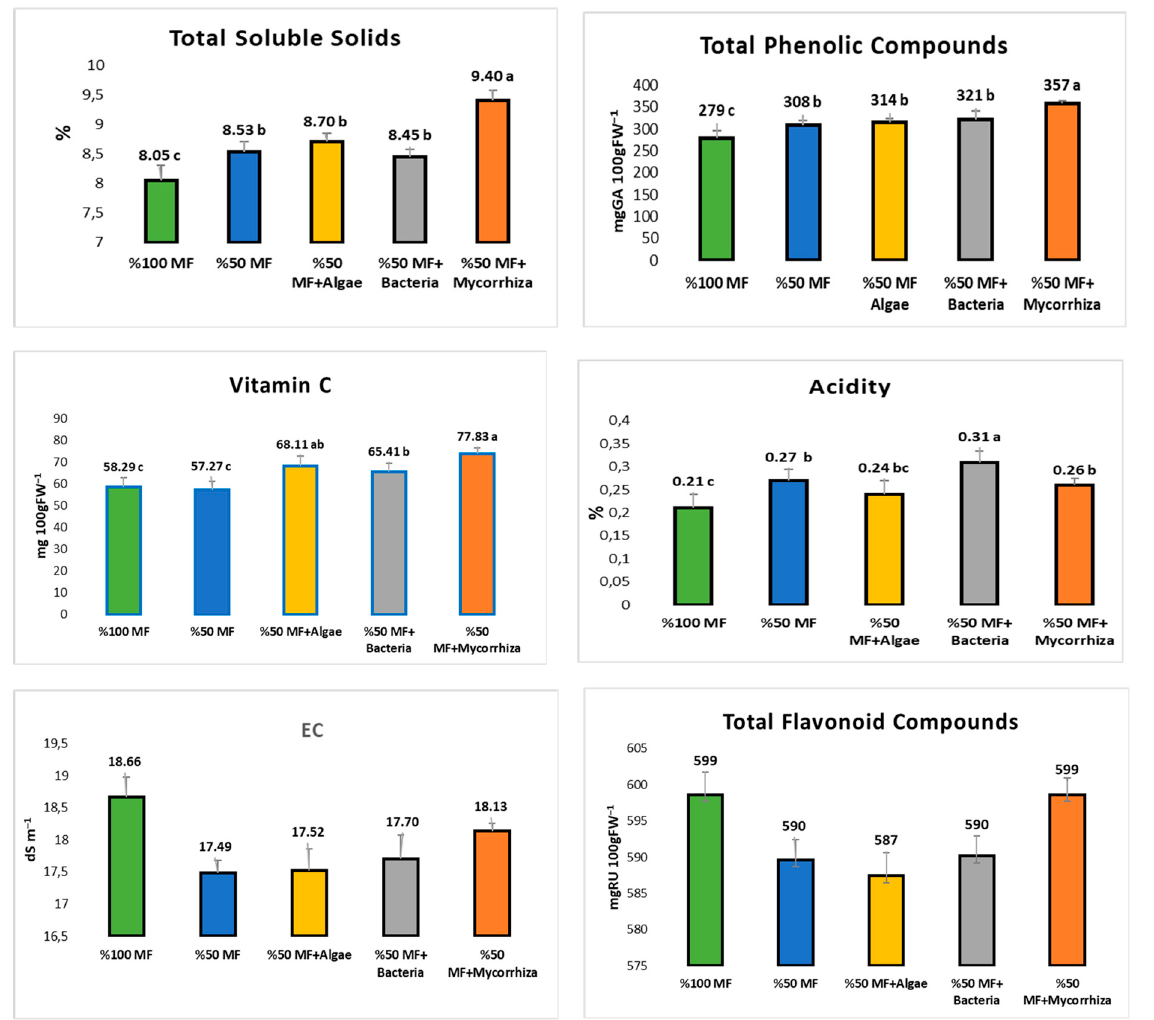
Figure 5. Effects of supplemental biofertilizers on leaf TSS (%), total phenolic compounds (mg GA 100 g FW − 1 ), vitamin C (mg 100 g FW − 1 ), titrable acidity (mg 100 g FW − 1 ), EC (dSm − 1 ) and total flavonoid compounds (mg RU 100 g FW − 1 ). There is no significant difference between means with the same letter in the same histogram, FW fresh weight, GA gallic acid, RU rutin.